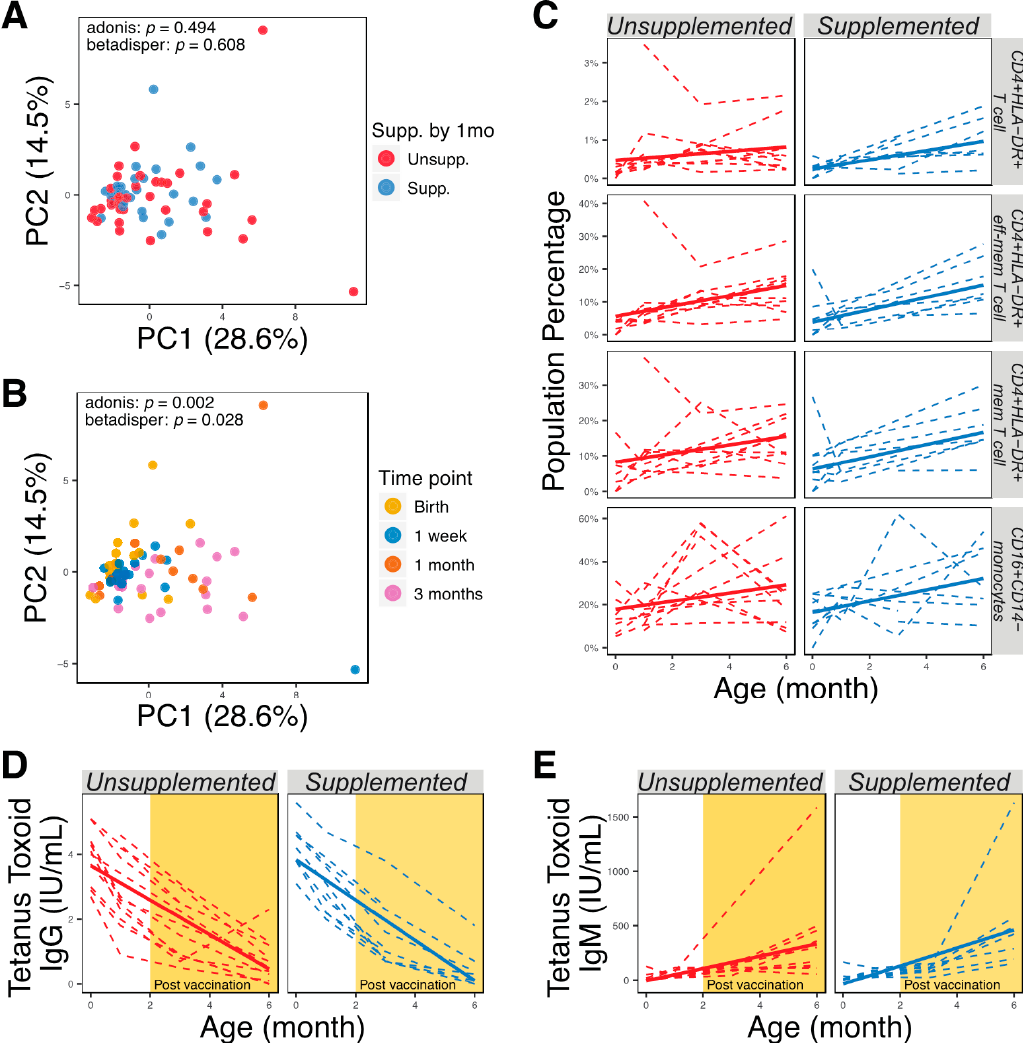
Figure 4. Similar immune development of supplemented and unsupplemented infants. ( A ) PCA plot generated using all immune markers measured, colored according to supplementation by 1 month. ( B ) PCA plot generated using all immune markers measured, colored by time point. ( C ) Immune cell populations that were significantly correlated with age (adjusted p < 0.05). ( D ) Quantification of anti-tetanus toxoid IgG in serum using ELISA. ( E ) Quantification of anti-tetanus toxoid IgM in serum using ELISA.